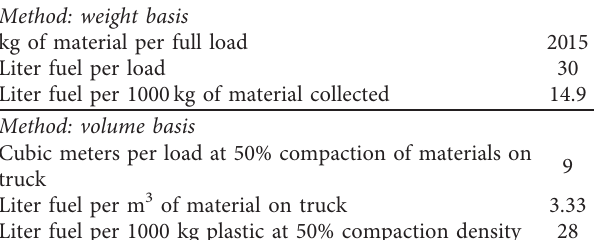
Table 3: Fuel consumption for the curbside collection